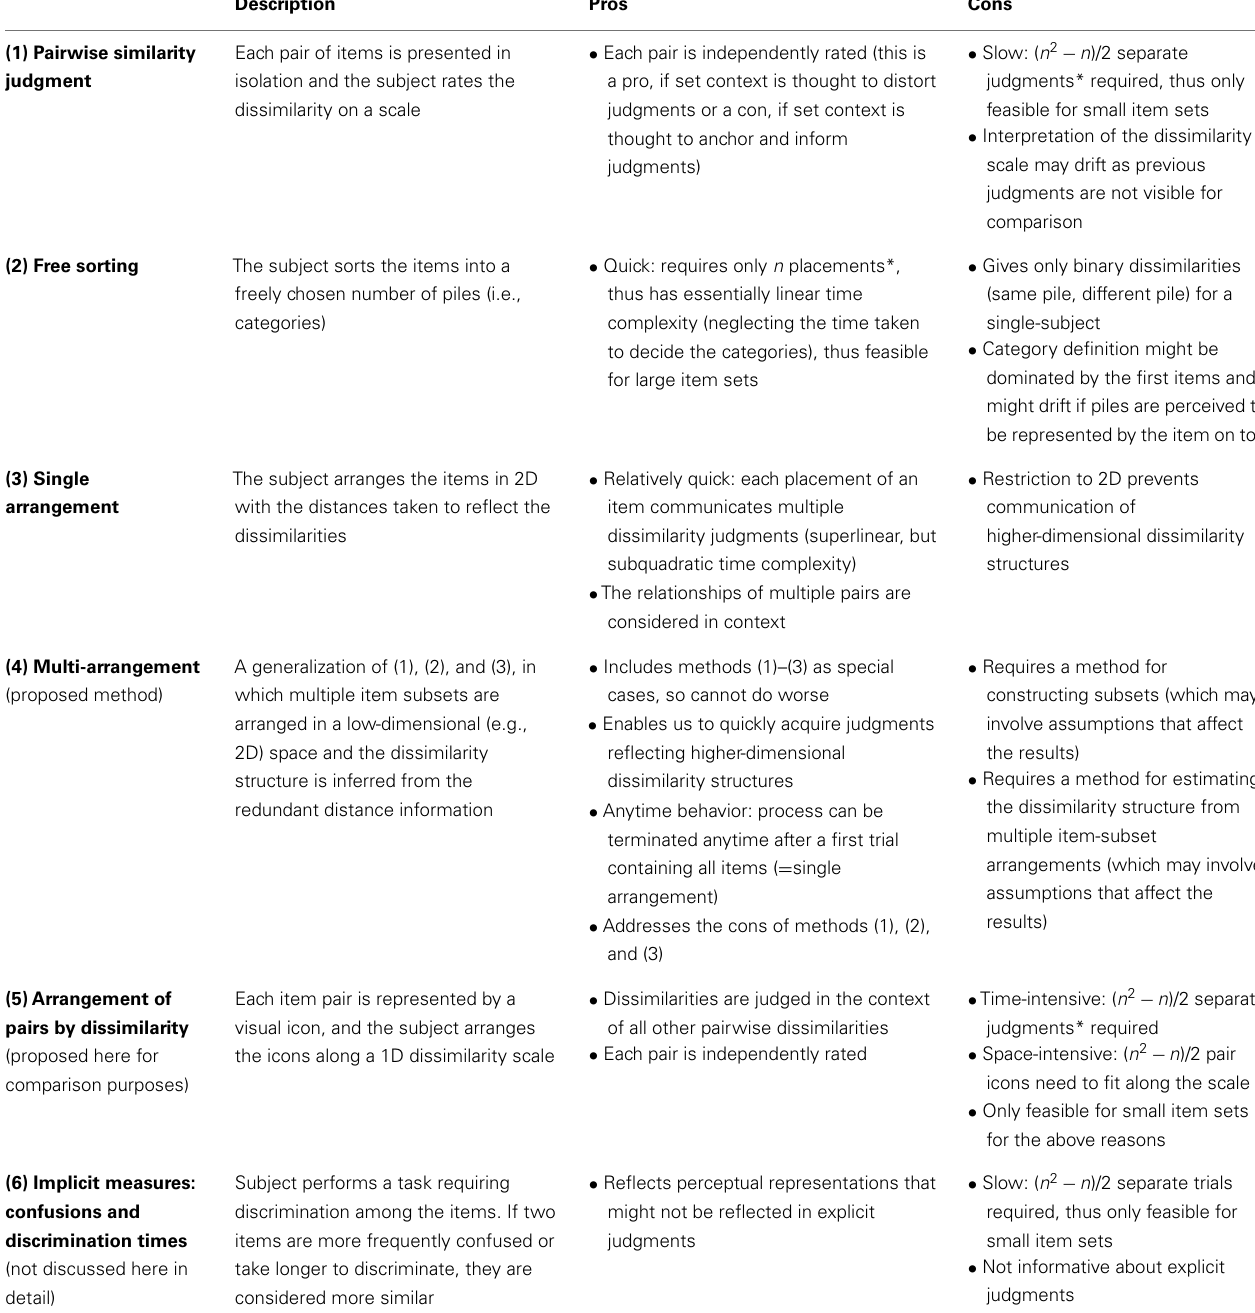
Table 1 | Different behavioral methods for acquiring